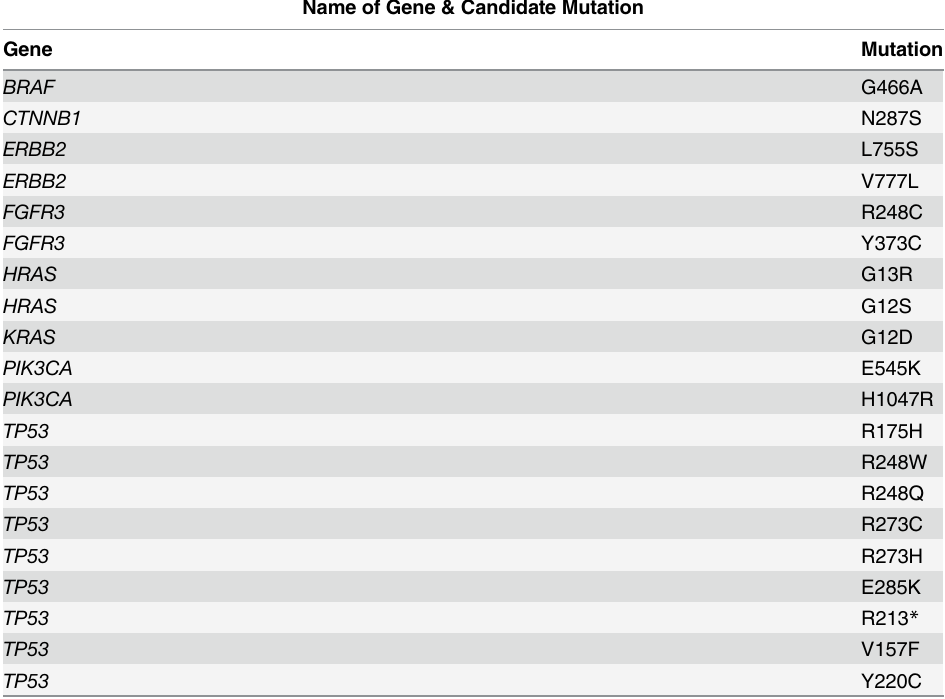
Table 2. Name of Gene & Candidate Mutation validated by hME.